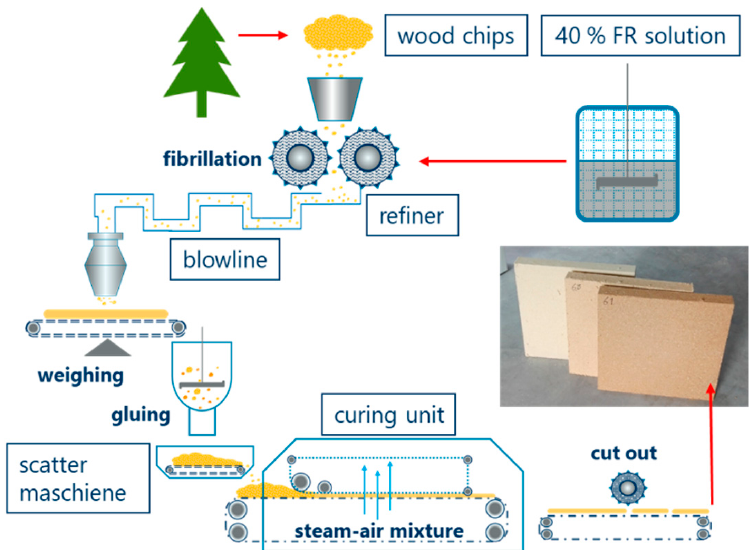
Figure 9. Scheme of the production line for the application of starch-based flame retardants to wood fiber material (illustration adapted from [61]), and photo of the wood fiber products (from left to right) without, with 5 and 10 wt.% fire retardant additive WS-E .